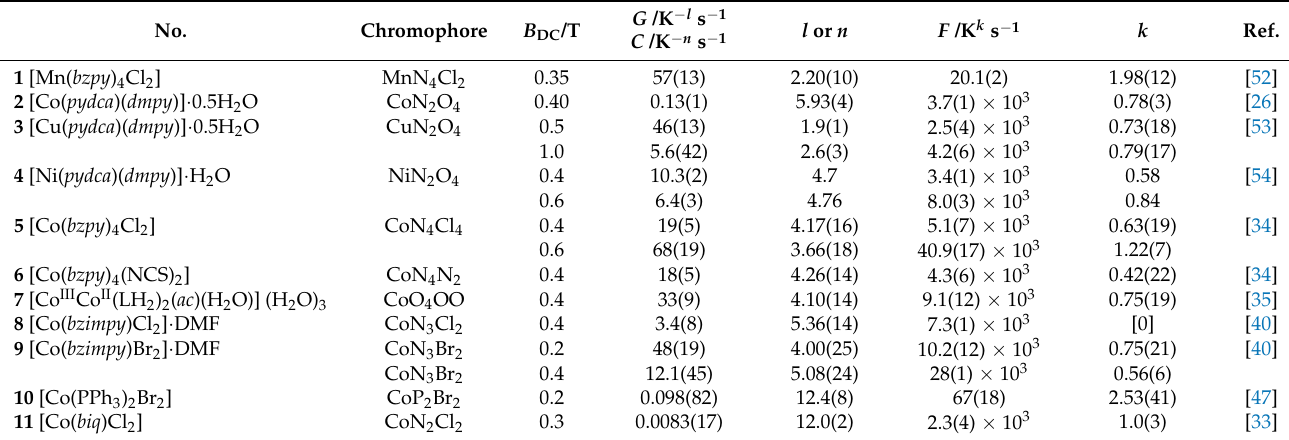
Table 3. Characteristics of the reciprocating thermal behavior for high-frequency channel of slow magnetic relaxation in transition metal complexes a